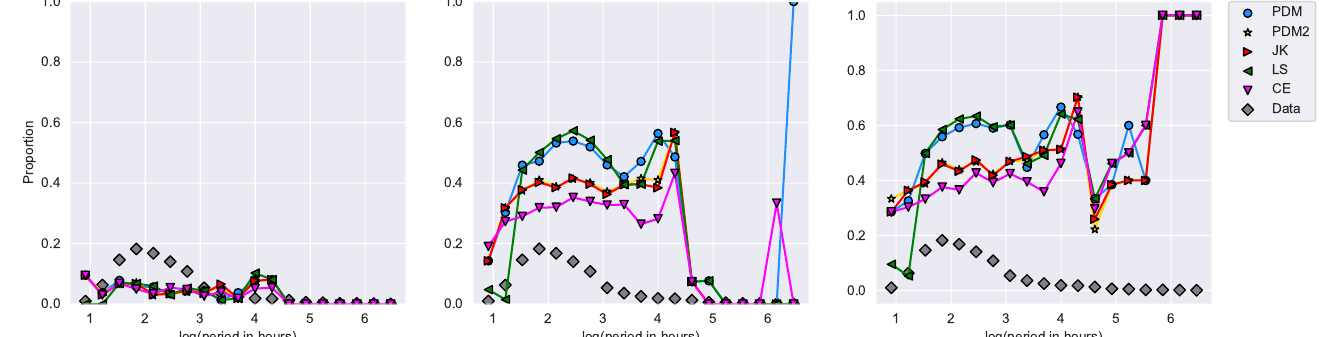
Figure 11. The comparison of different period finding algorithms considering the different reported periods for the step size of 10 − 4 h and the range of 2 h–40 h of period searching. The criterion for comparison is the proportion of asteroids having a successful periodic recovery. From left to right, the three plots are for different δφ max = 85/50,850/50 and 8500/50. The gray diamonds indicate the proportion of asteroids at the corresponding reported period in our data set.